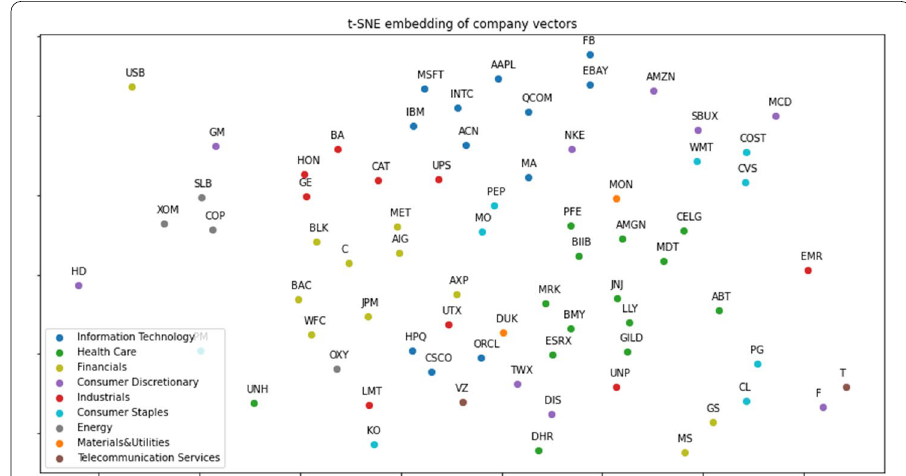
Fig. 9 t-SNE embedding of company vectors in word2vec